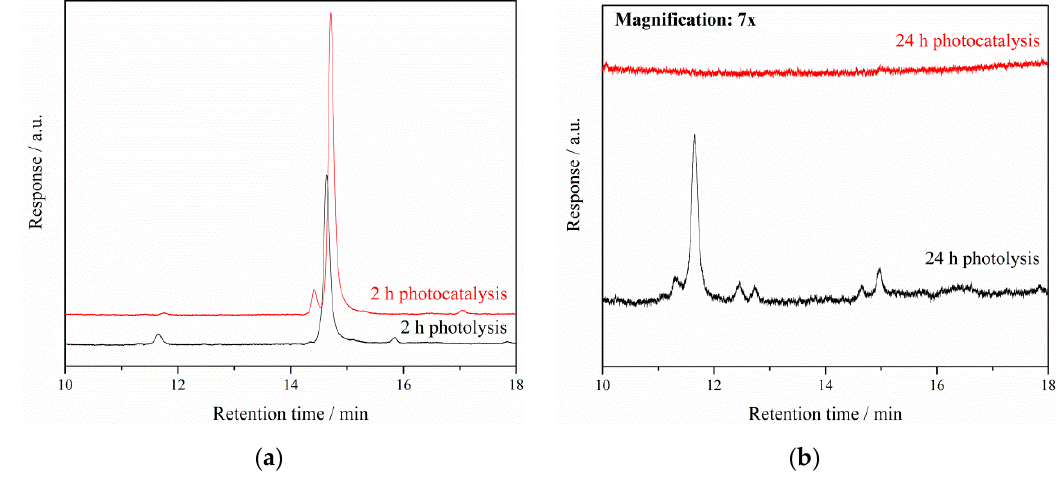
Figure 5. Chromatograms of SFX under both photocatalytic and photolytic conditions upon irradiation with UV(A) light after: ( a ) 2 h and ( b ) 24 h.